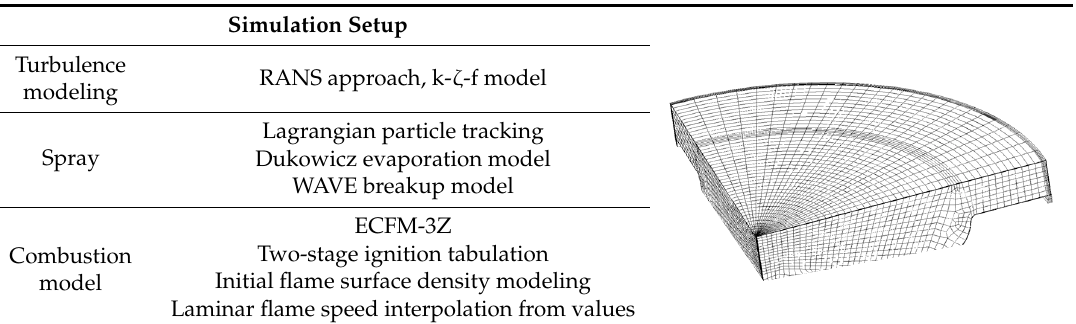
Table 4. Numerical setup for the engine simulations.